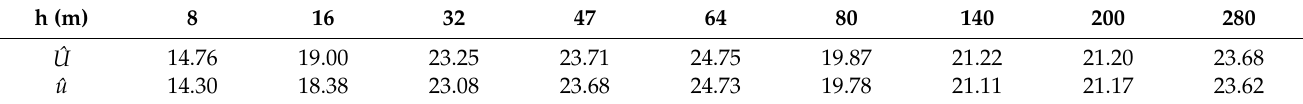
( b ) Figure 6. Vertical wind speed (blue) and wind attack angle (red) time history of the thunderstorm recorded at 16 m ( a ) and 64 m ( b ) . According to the upper air map and sounding data of the day, the severe convective weather was mainly caused by the northeast cold vortex, and the weather was supposed to be a thunderstorm gale of the northwest flow type. From 8:00 to 14:00, the convective effective potential energy increased from 0 to 954.8 J/kg, and the wind shear at the lower level was moderately strong vertical, reaching 3.1 × 10 −3 s −1 between 0 and 2 km. The wind index reached 28 m/s, the temperature difference between 500 and 850 hPa was 32 °C, and the temperature decline rate was 0.8 °C/hm, presenting the typical weather features of thunderstorm wind [30].